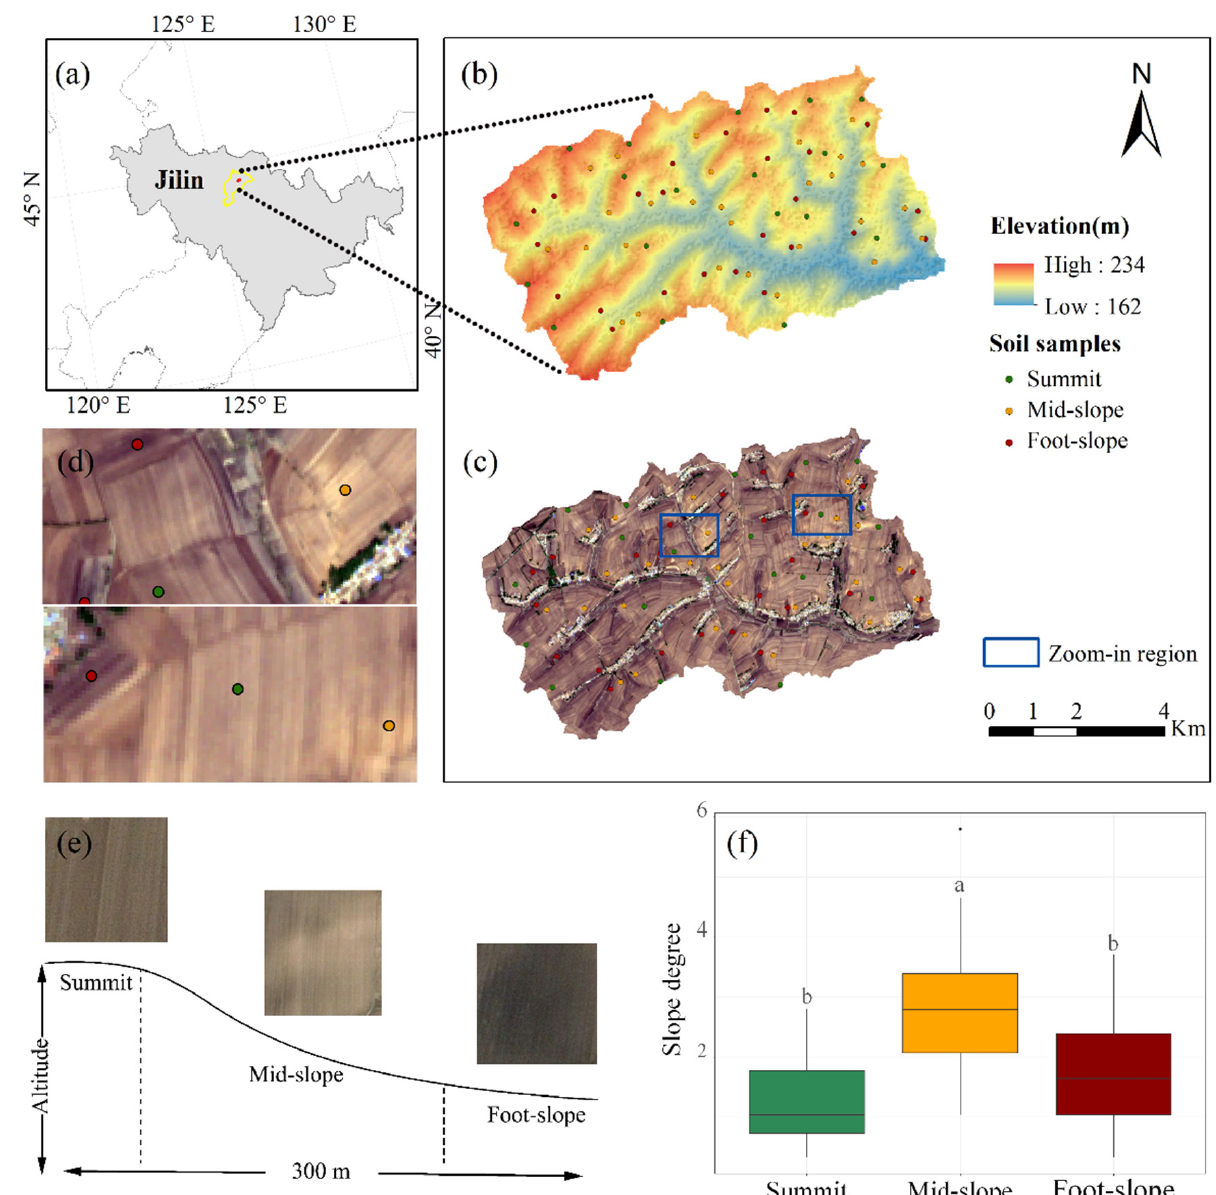
Figure 1. ( a , b ) Spatial distribution of the sampling points overlaid on the digital elevation model of the catchment in northeast China; ( c , d ) a Sentinel-2 true color image (13 May 2021) of the catchment showing the large percentage of exposed bare soils, and zoom-in areas depicting the selection of sampling points; ( e , f ) representative sampling locations along typical slope profiles with average length at ca. 300 m and their corresponding slope degrees. Different letters indicate significant differences among the three groups ( p <